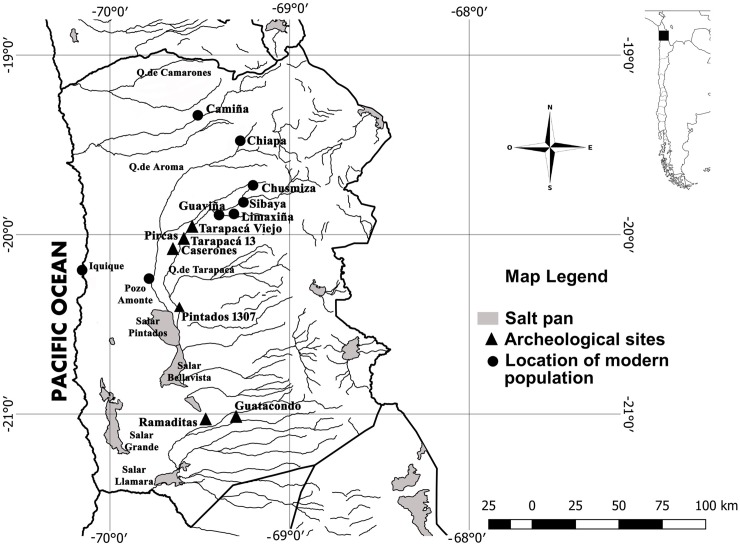
Tarapacá region map.Black triangles indicate archaeological sites dated between Formative Period (ca. 1500–500 yr BP) to Late Period (600–400 yr BP). Black dots indicate modern populations of maize used in this study.